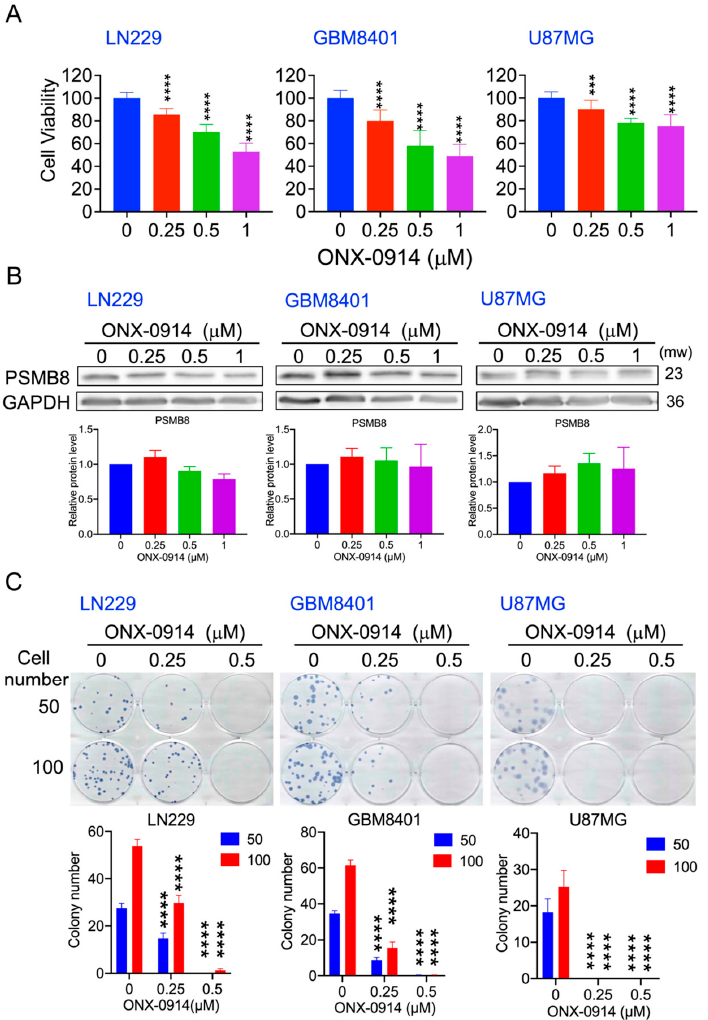
Figure 1. The effect of ONX-0914 on glioblastoma cell viability. ( A ) Cell viability was measured by MTT assays after glioblastoma cells were treated with ONX-0914 for 24 h. ( B ) PSMB8 protein expression was evaluated by Western blotting after ONX-0914 treatment for 24 h. The quantification is shown below. GAPDH was used as a loading control. ( C ) A total of 50 or 100 cells were seeded in 6-well dishes for the colony formation assay. ***, p < 0.001; ****, p < 0.0001 compared to the control